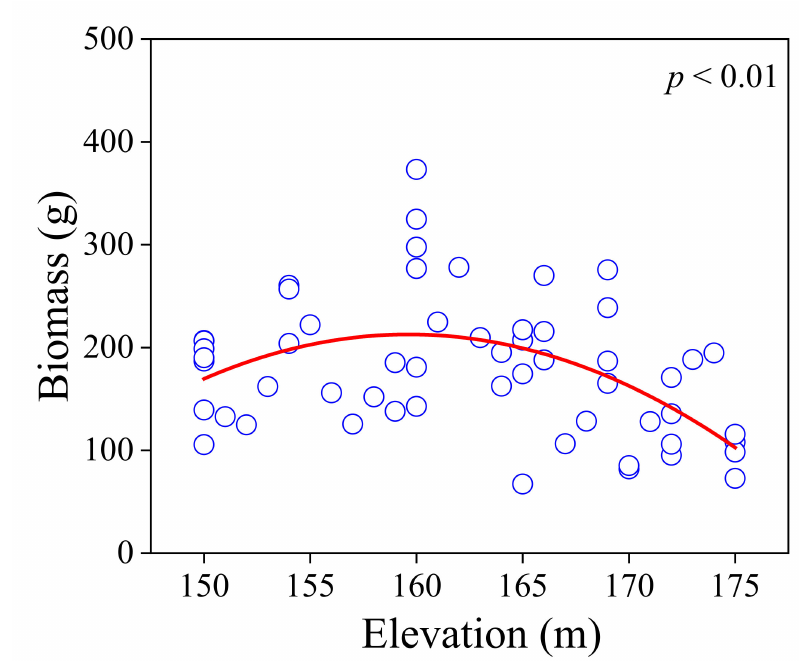
Figure 3. Effect of elevations on the aboveground biomass